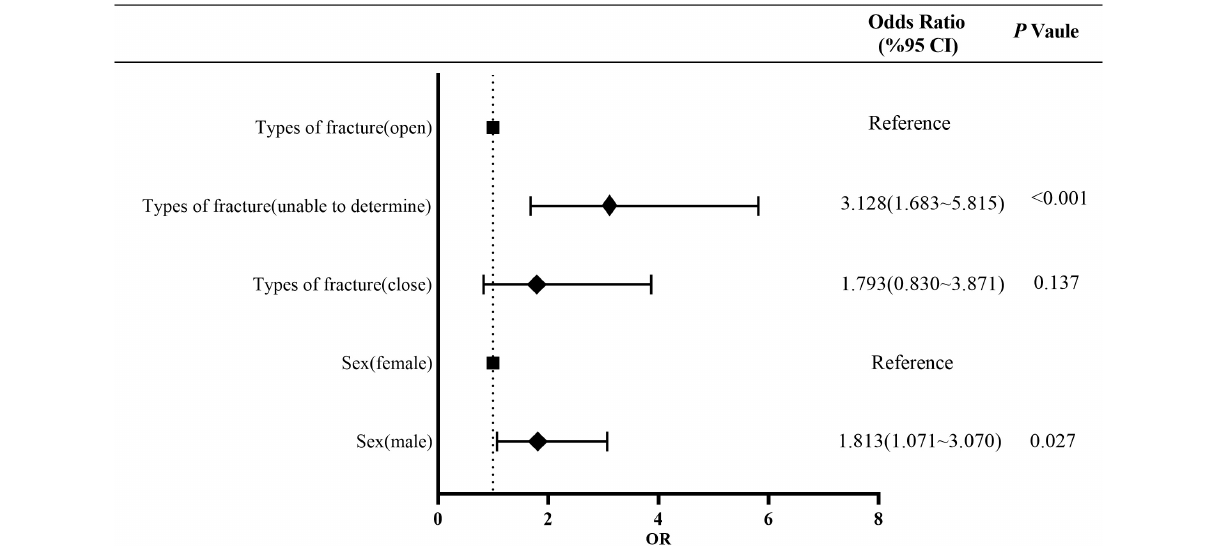
FIGURE 3 | Multivariate risk factor analysis of MP population. MP, monomicrobial infection of positive bacteria.